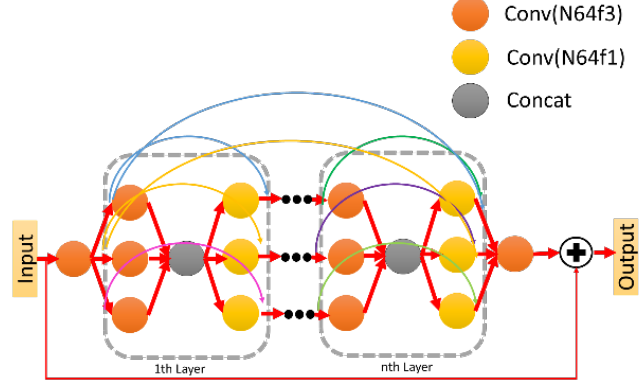
Figure 3. The convolutional layers with 2D